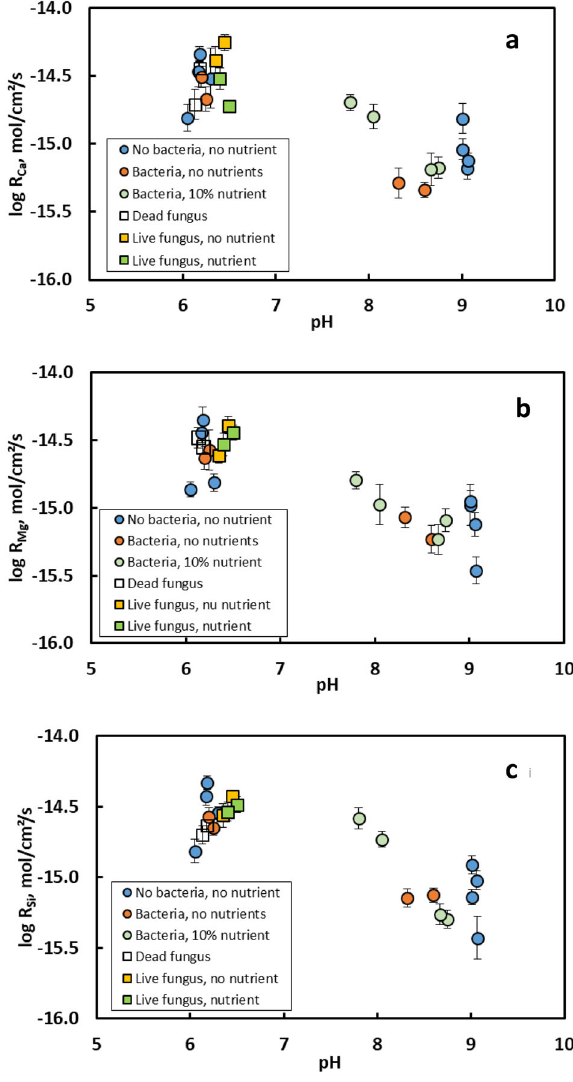
Fig. 1 Results of diopside dissolution in experimental reactors. Calcium ( a ), Mg ( b ), and Si ( c ) release rates from diopside measured in the mixed- fl ow reactor with and without bacteria and 10% nutrient or nutrient-free solution and in the batch reactor in the presence of